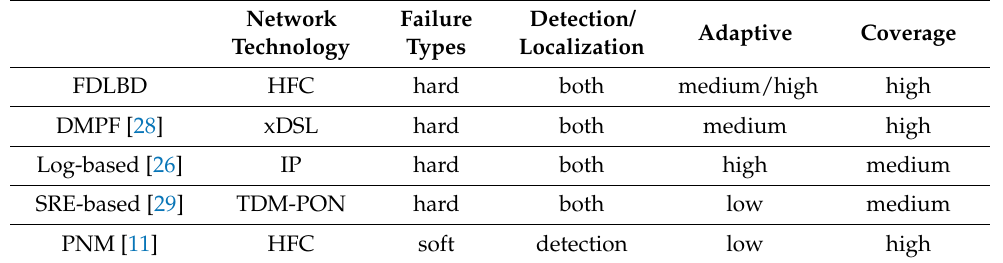
Table 2. Comparison